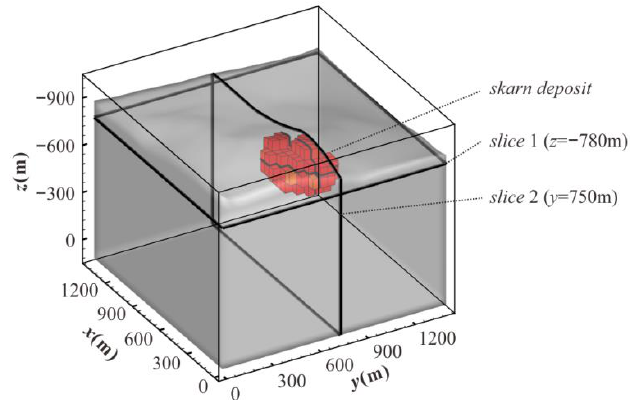
Figure 24. Interpretation of skarn deposit in three dimensions.